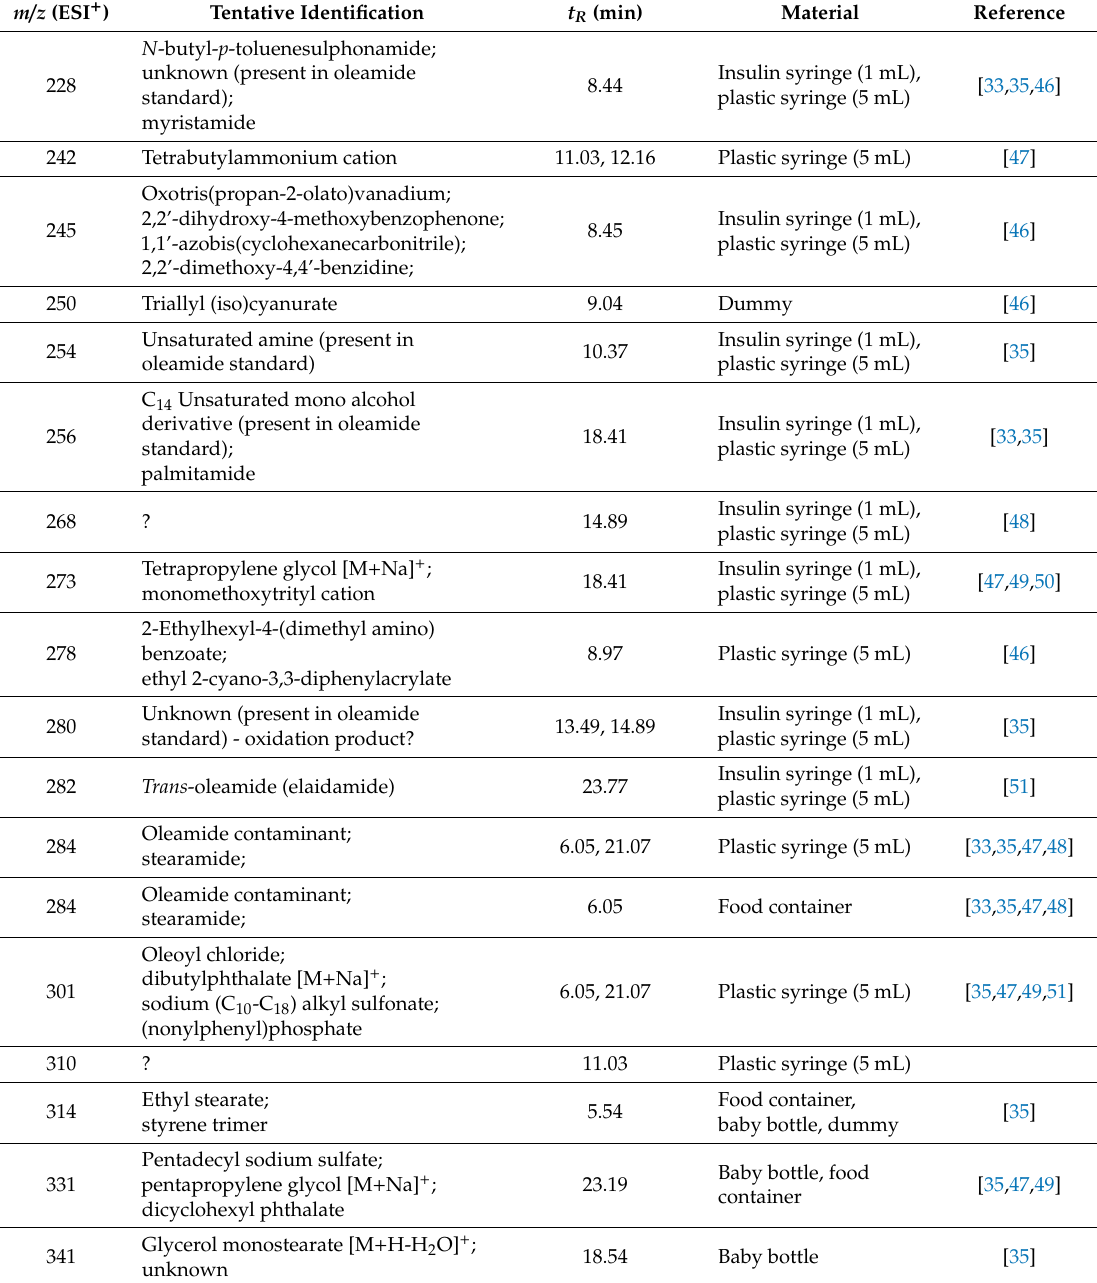
Table 3. Tentative identification of some frequently occurring contaminants, observed in the LC-MS chromatograms of the analyzed